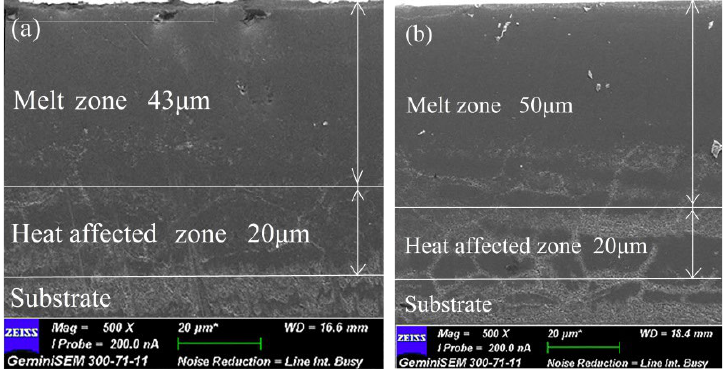
Figure 6. SEM images of cross-sections: ( a ) laser polishing and ( b ) laser annealing. Detected by the FM-800 micro-Vickers hardness tester, the microhardness of the laser-polished surface was 553 HV at the depth of 10 µ m, and then it decreased significantly with the increase of the depth until the depth reached 90 µ m, as shown in Figure 8. The microhardness tended to be stable (370 HV), i.e., close to the hardness of the 718H substrate. Meanwhile, the microhardness of the laser-annealed surface was 542 HV at the depth of 10 µ m, and then it decreased with the increase of the depth. When the depth was 90 µ m, the microhardness of the laser-annealed surface was slightly higher than that of the laser-polished surface.